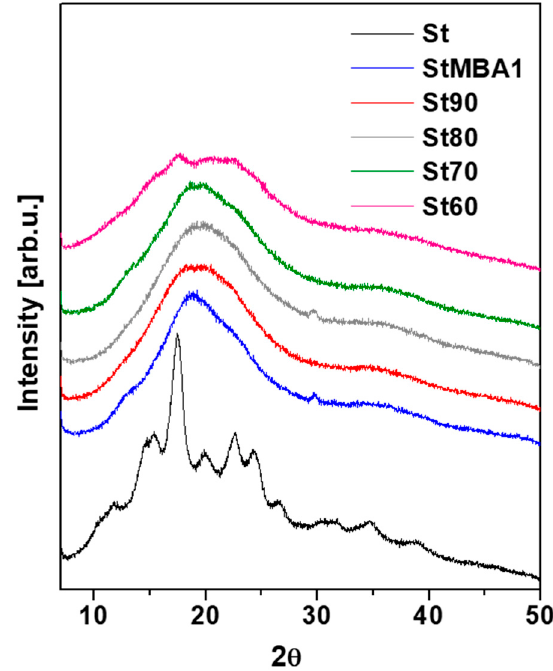
Figure 6. Wide angle X-ray powder diffraction spectra for potato starch, crosslinked starch and starch SAPs.